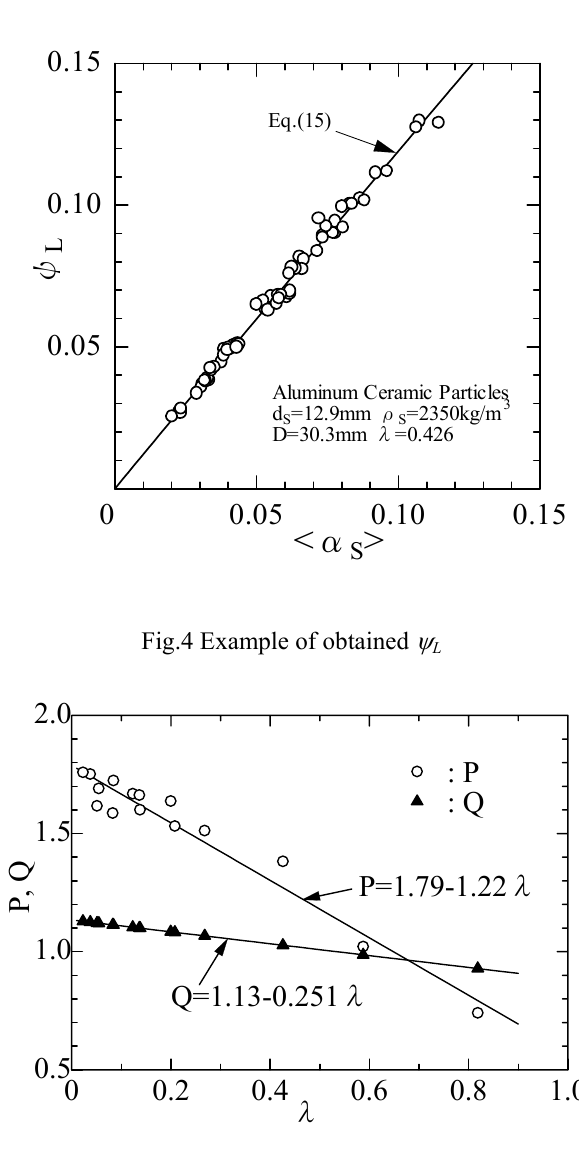
Fig.5 Coefficient P and exponent Q with their